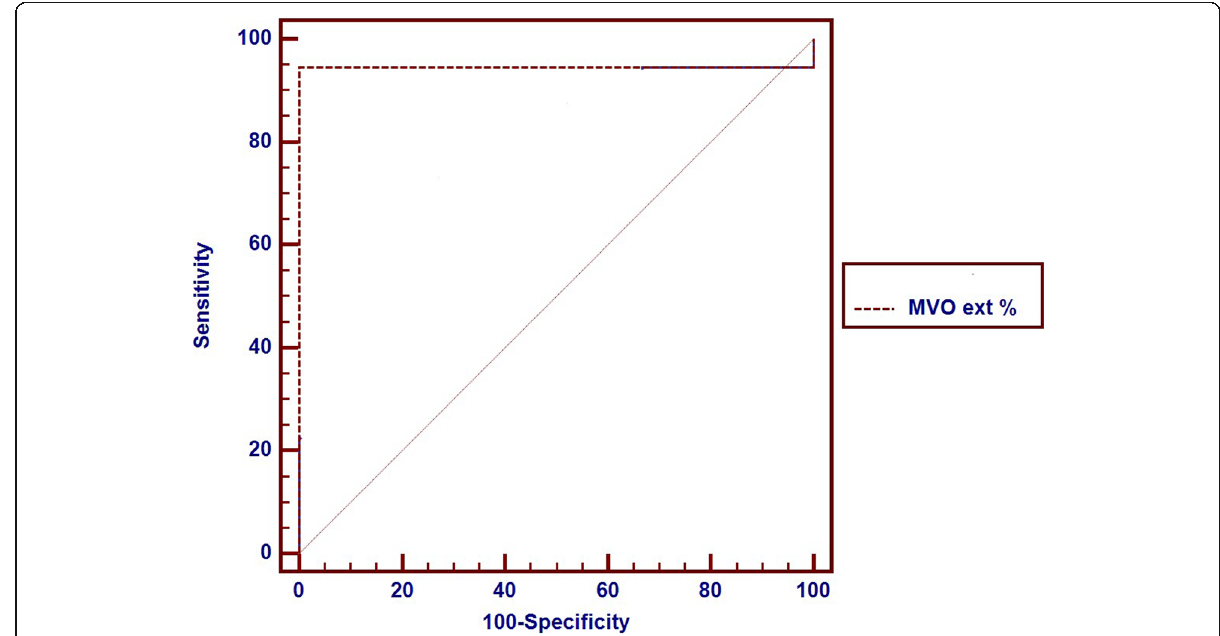
Fig. 11 ROC curve for the predictors of a good